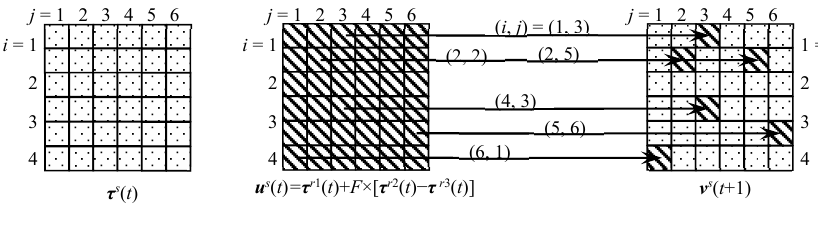
Figure 3. The crossover process of the pheromone matrix.